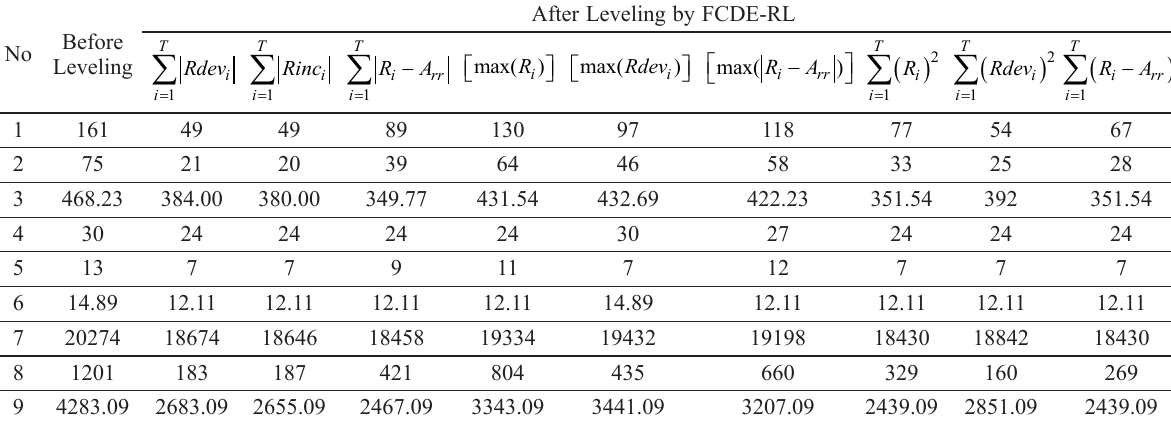
After Leveling by